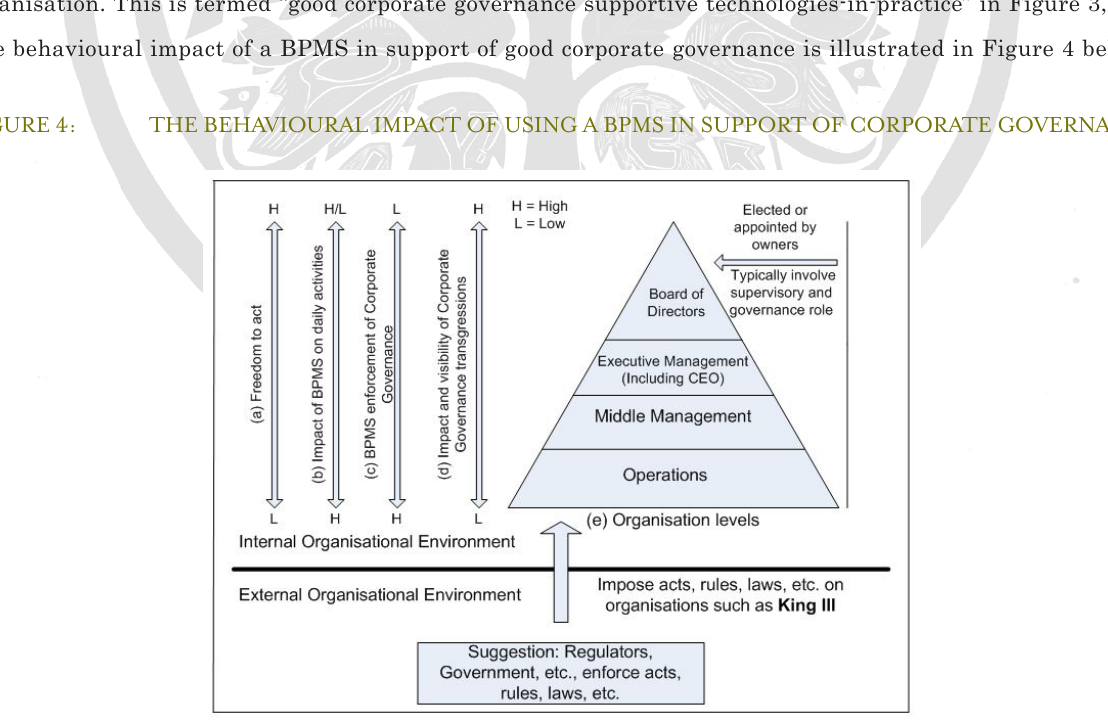
THE BEHAVIOURAL IMPACT OF USING A BPMS IN SUPPORT OF CORPORATE